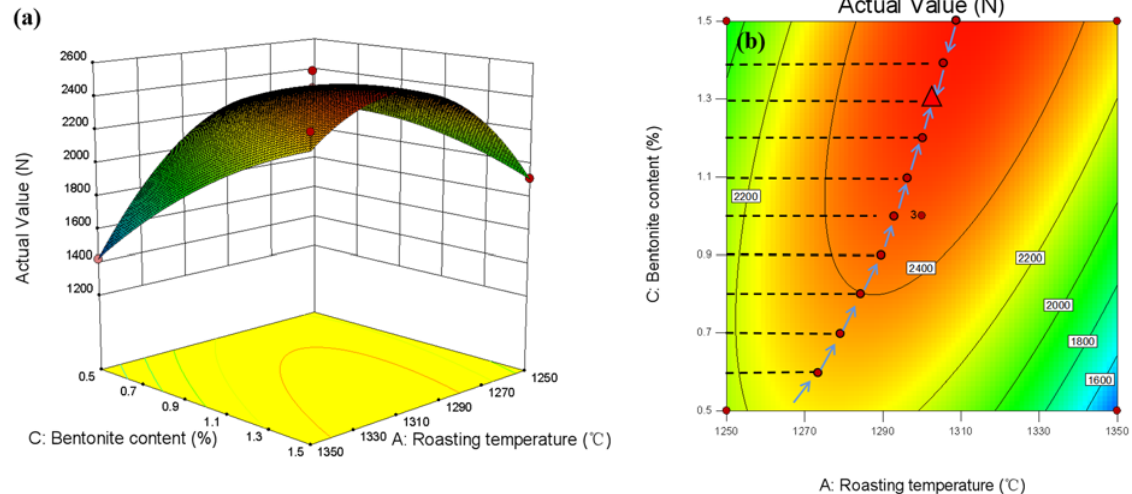
Figure 18. Response surface diagram between roasting temperature, bentonite content, and pellet compressive strength: ( a ) 3D response surface plot, ( b ) optimal parameter contour plot.